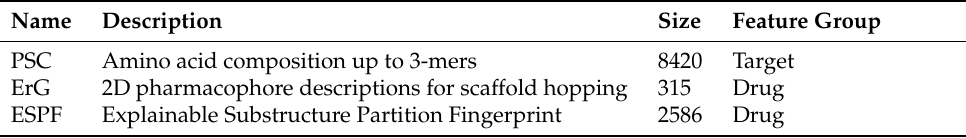
Table 4. Summary of structural features used for protein and fingerprint features for